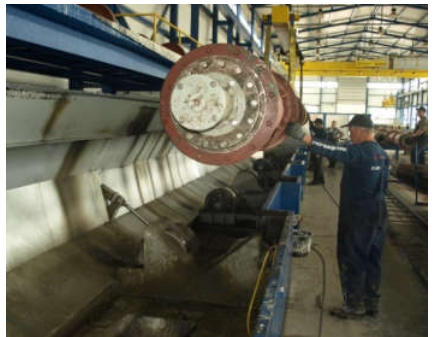
Figure 2. Steel mould with attached little mould is being placed in centrifuge.